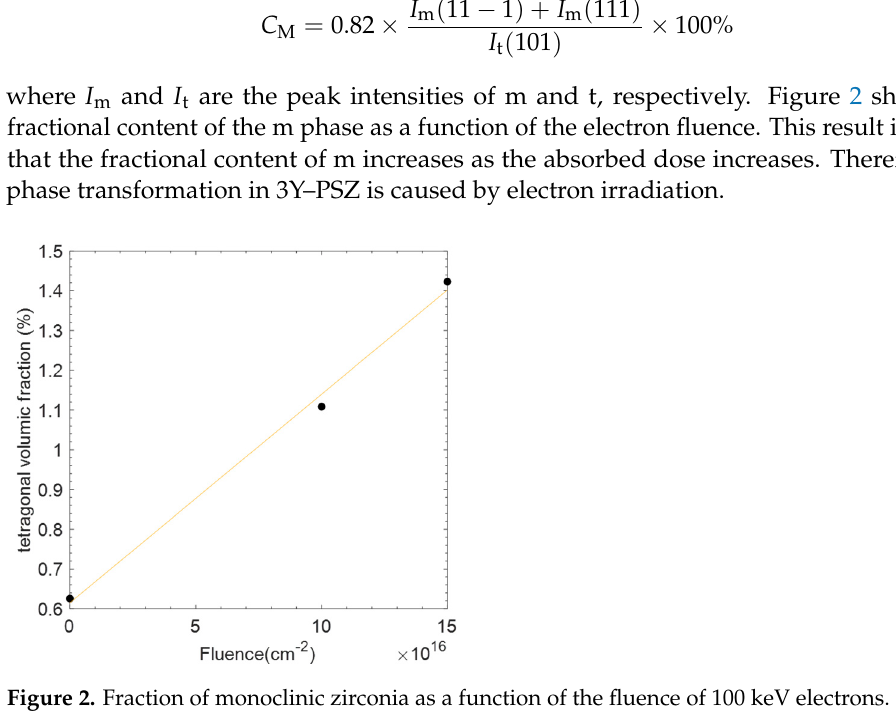
the X-ray penetration depth. The fraction 𝐺(cid:4666)𝑥(cid:4667) of the total diffracted intensity, due to a surface layer of depth 𝑥𝑥 , can be expressed using the following [17,18]: